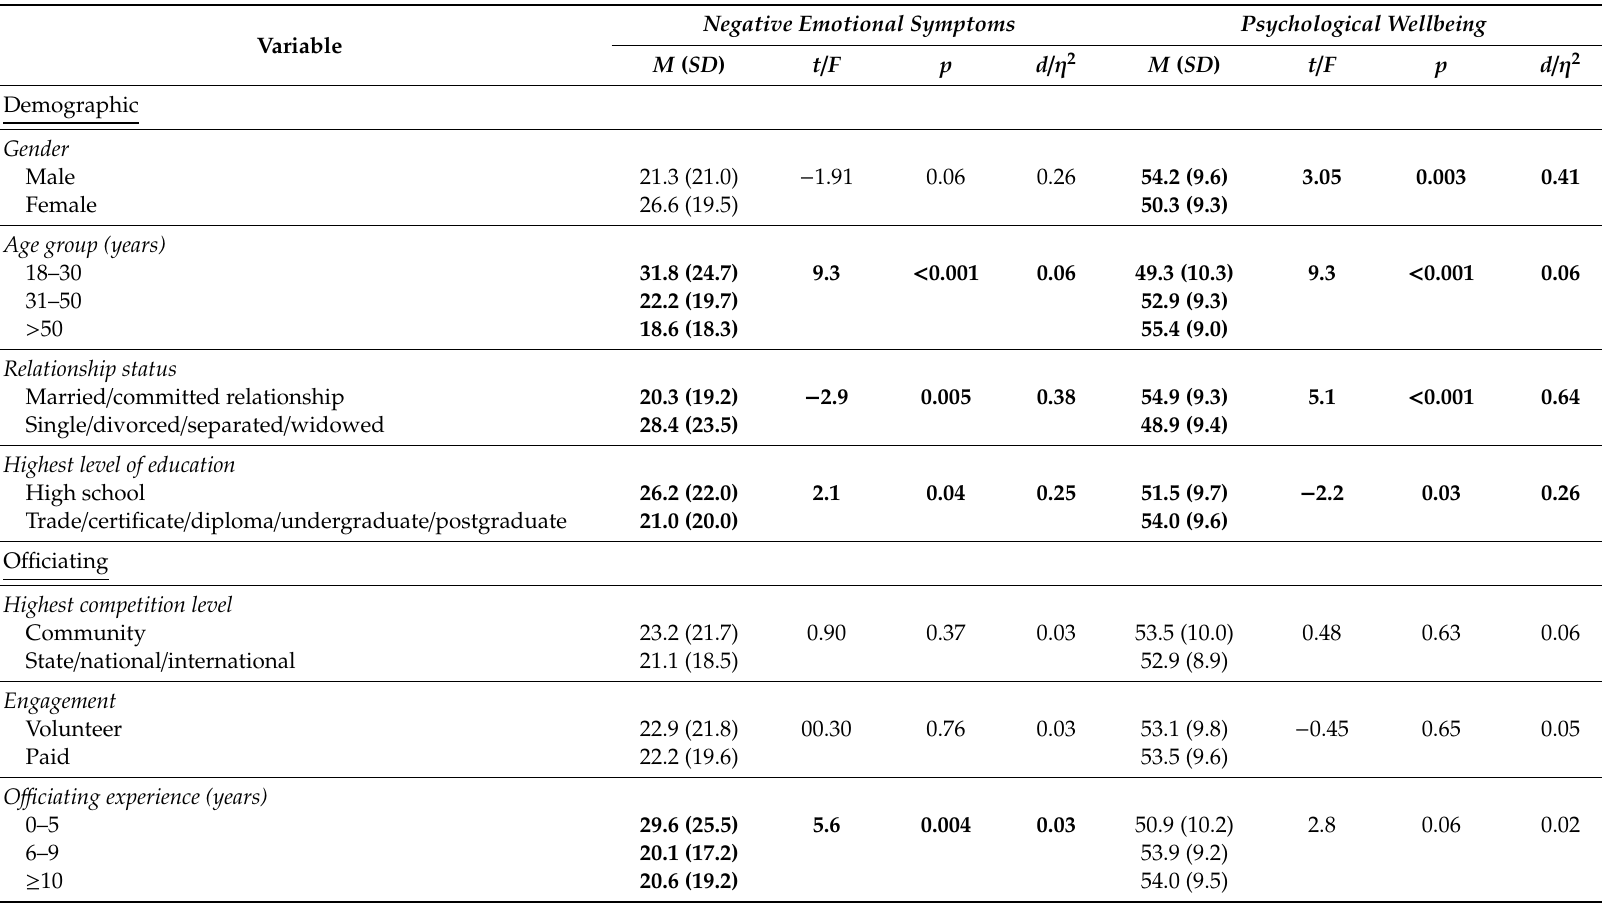
Table 3. Negative emotional symptoms (DASS-21 composite) and psychological wellbeing (WEMWBS total score) for o ffi cials’ subgroups.